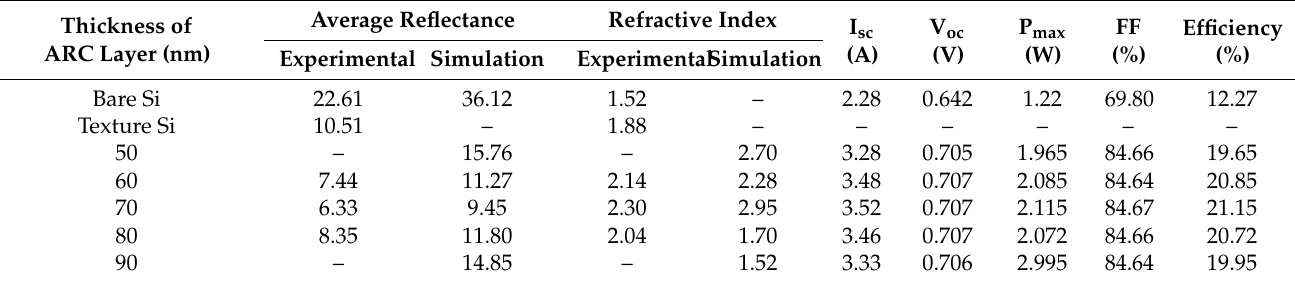
Table 2. Photovoltaic parameters of HfO 2 ARC-based c-Si solar cell.